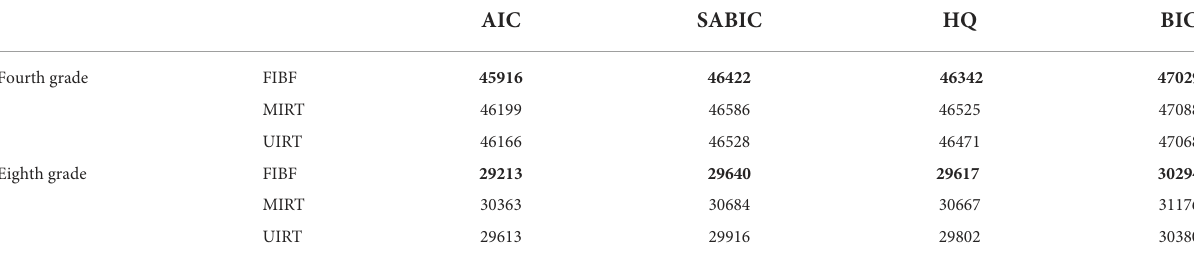
TABLE 1 Four model selection indices (AIC, SABIC, HQ, and BIC) of the three competing models (FIBF, MIRT, and UIRT) for fitting the mathematics test data of the fourth and eighth grades in CCEQM 2015–2017. AIC SABIC HQ